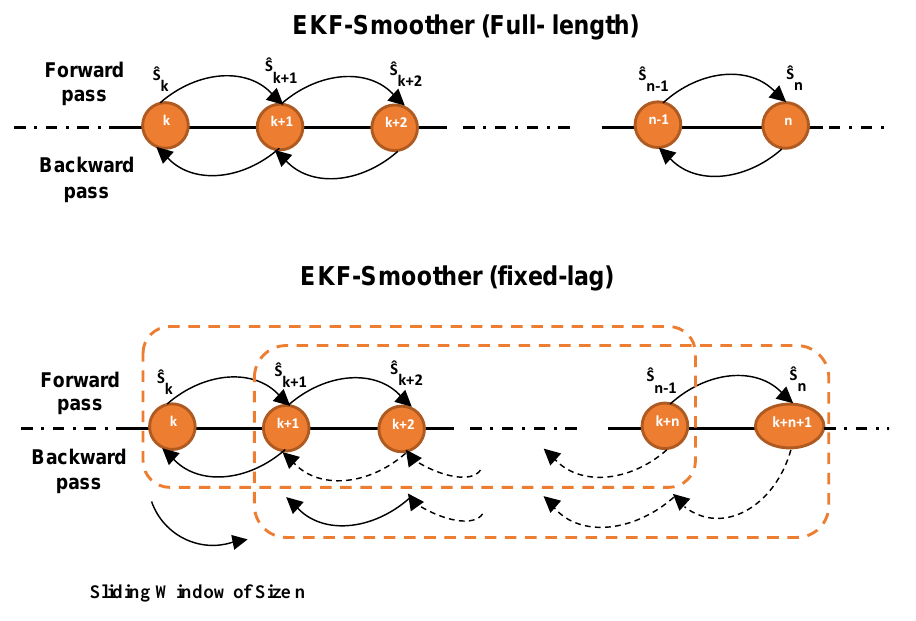
Figure 1. The process of the ( Top ) EKF-Smoother fixed-lag and ( Bottom ) EKF-Smoother Full-length